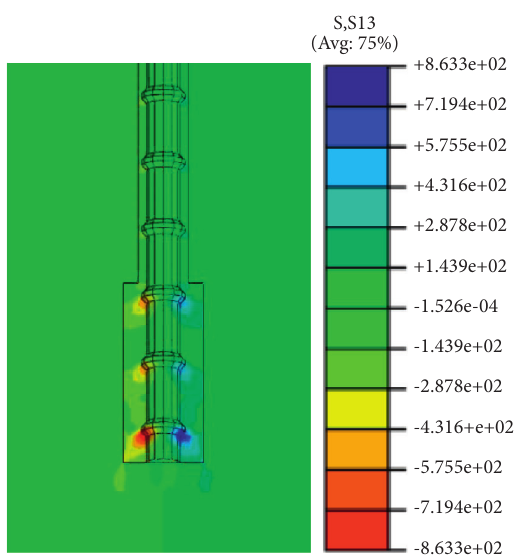
Figure 9: Shear stress distribution of cement soil at the enlarged base and surrounding soil ( Q 3 ).